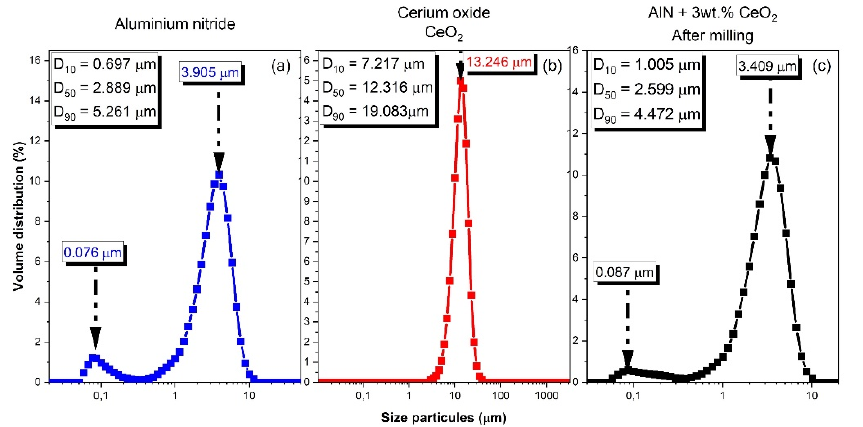
Figure 2. Particle size distribution of ( a ) aluminum nitride raw powder; ( b ) yttrium oxide raw powder; ( c ) AlN + 3 wt.% CeO 2 after milling.